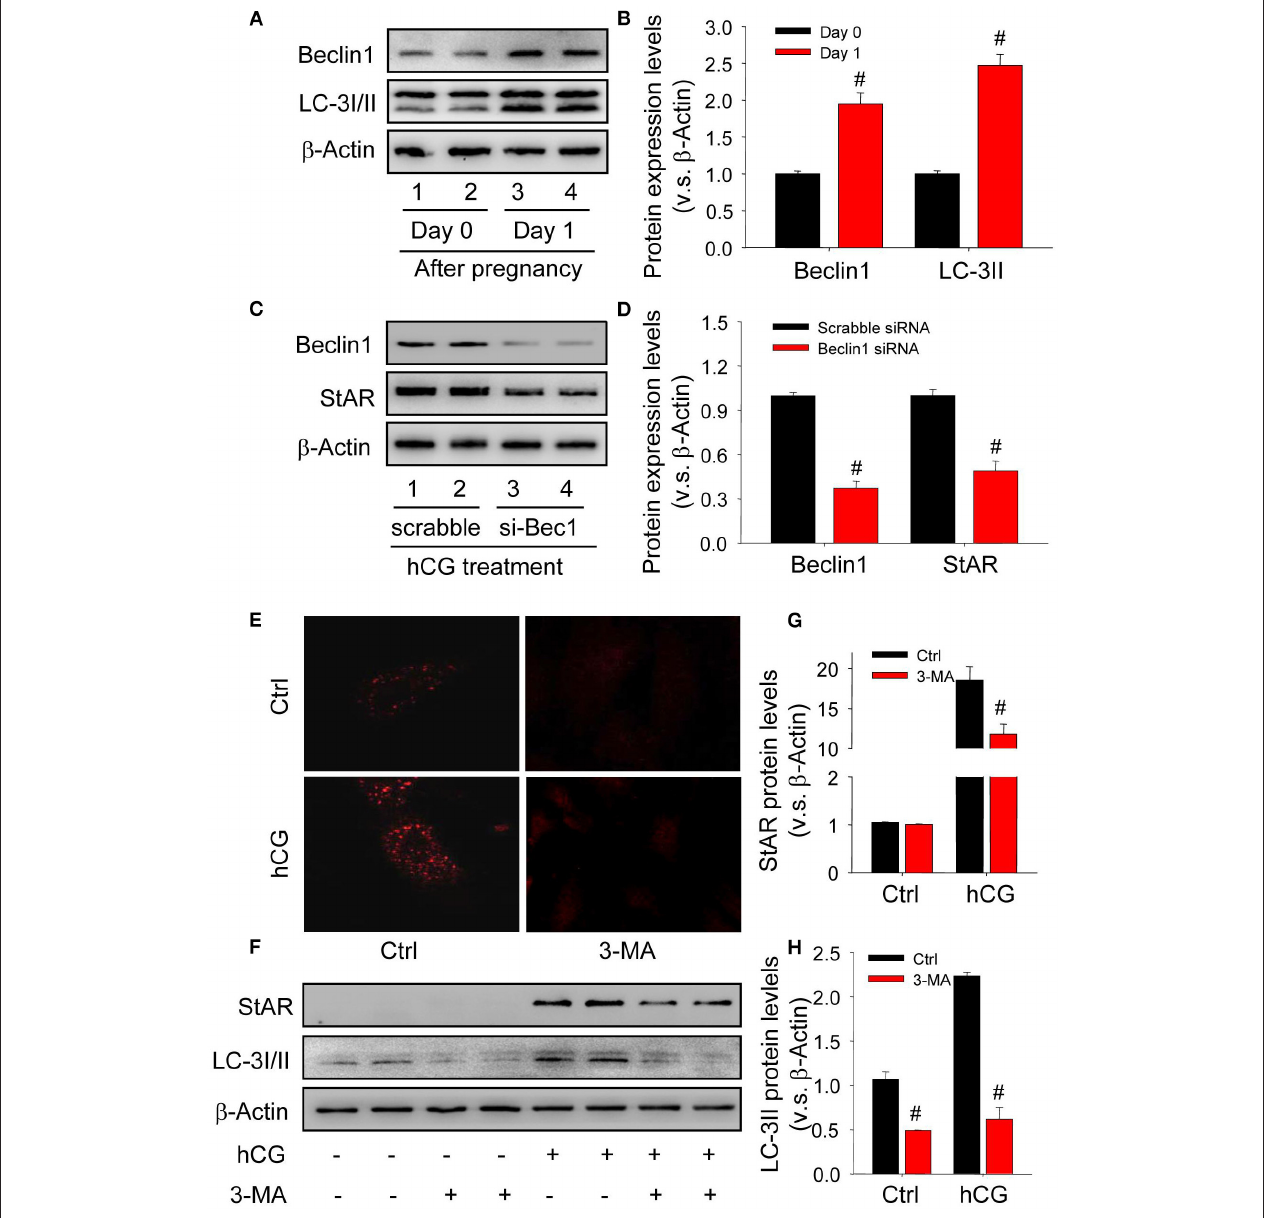
FIGURE 2 | Autophagy is induced during the luteinization of granulosa cells in vivo and in vitro . (A) The expressions of autophagy marker proteins LC-3I/II and beclin1 on Day 0 or 1 after pregnancy were detected by Western blot. (B) Summarized intensities of StAR blotting normalized to the control (Day 0). (C) Granulosa cells were transfected with siRNA targeting beclin1 for 36h, and then treated with hCG for 48h. The expressions of beclin1 and StAR were analyzed by Western blot. (D) Summarized intensities of beclin1 and StAR blotting normalized to the control (scrabble siRNA). (E) Immunofluorescence of LC-3I/II in granulosa cells was pretreated with/without hCG and then treated with/without 3-MA for 24h. (F) The expression changes of LC-3I/II and beclin1 detected by Western blot in granulosa cells pretreated with/without hCG (15 IU/ml) for 48h and then treated with 3-MA (10mM) for 24h before analysis. (G) Summarized intensities of StAR blotting normalized to the control. (H) Summarized intensities of LC-3II blotting normalized to the control. Each value represents the mean ± SE. One-way analysis of variance (ANOVA) was used to analyze the data, followed by a Tukey’s multiple range test. n = 6. Ctrl, vehicle; scrabble, scrabble siRNA; si-Bec1, siRNA targeting beclin1; hCG, human chorionic gonadotropin; 3-MA, 3-methyladenine, # P < 0.05 , vs. the group in black.